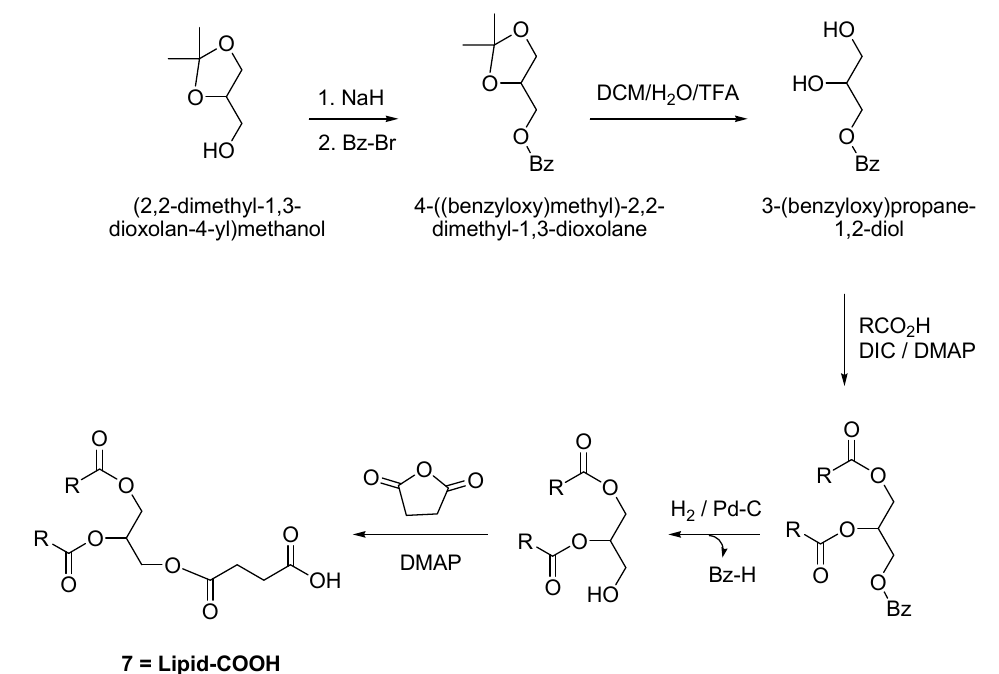
Figure 3. HPLC analysis of ( A ) the reaction mixture product between bis(2-aminophenyl) disulfide and palmitoyl chloride in presence of NEt 3 ; ( B ) the reaction mixture after reduction with NaBH 4 and acidification with AcOH; Column: LiChrospher ® 100 RP-18 (5 µm) LiChroCART ® 250-4; Mobile phase: THF/H 2 O; Gradient: 50% THF to 100% THF in 30 min; Flow rate: 1mL/min; Detection at 254